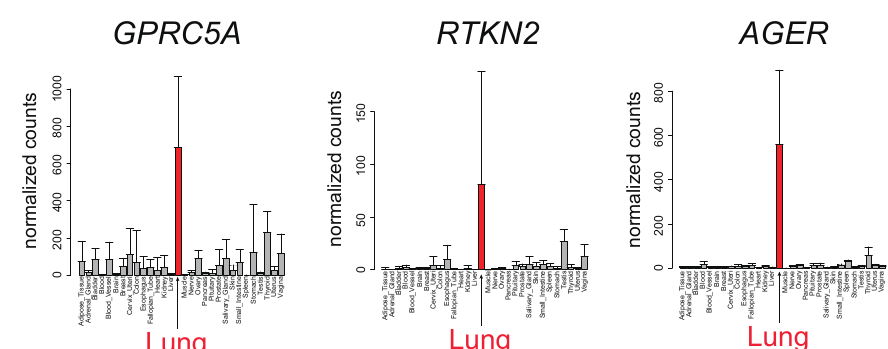
Figure 4. High expression of Gprc5a , Rtkn2 and Ager in AT1 cells and lung. ( A ) Flowchart for identifying AT1 cell- and lung-enriched genes. ( B ) UMAP of scRNA-seq data from Mouse Cell Atlas [28] with Gprc5a , Rtkn2 and Ager . Blue and grey indicate high and low expression (determined by absolute read count), respectively. ( C ) Gene expression of GPRC5A , RTKN2 and AGER in lung (red) and 29 other organs (grey) from GTEx database. Counts per million was used for normalization between samples.